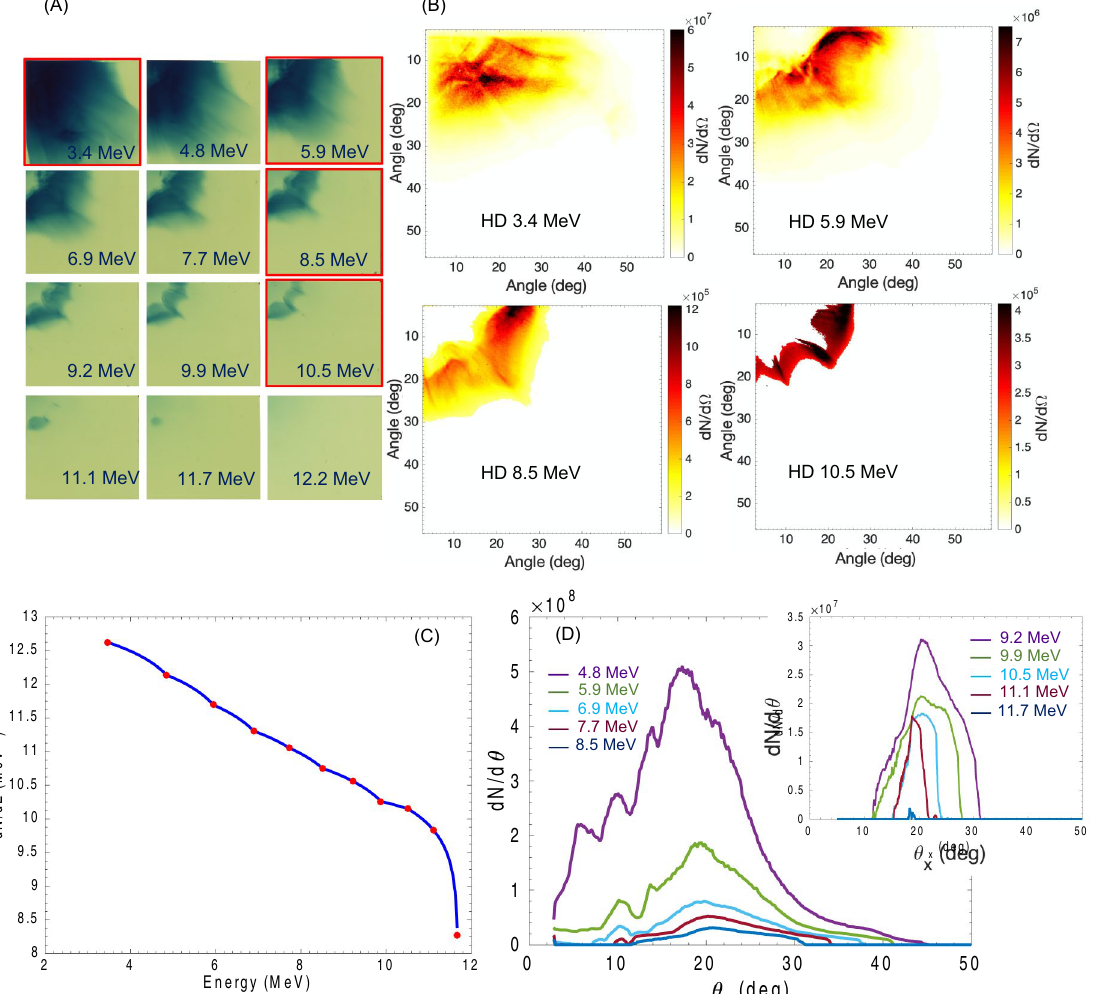
Figure 2. Example of experimental and post-processed data for free-standing cone target. ( A ) Raw RCF data showing the proton beam distribution for free-standing cone target. The RCF film corresponding to the post processed data in (B) are framed in red. ( B ) Post-processed data with 3-dimensional spectral unfolding showing the angularly resolved proton energy spectrum. The post-processed results are displayed in different color-scale to make them clear to the reader. The unit of solid angle d (cid:31) is fixed at 7 × 10 –6 sr. Clear ring-like pattern with large divergence is observed, with complete absence of protons in a 0.225 sr solid angle for energies > 6 MeV. At lower energy we can observe presence of protons emitted more at smaller angles. However, post-processed data show that even at low energies the distribution presents the ring-like pattern with average divergence angle > 10°. ( C ) Proton energy spectrum obtained from the spectral unfolding of the RCF data. ( D ) Angular distribution of the proton beam for all energies, the inlet image shows the angular distribution for protons with energy ≥ 9.2 MeV which are not clearly visible in the large format